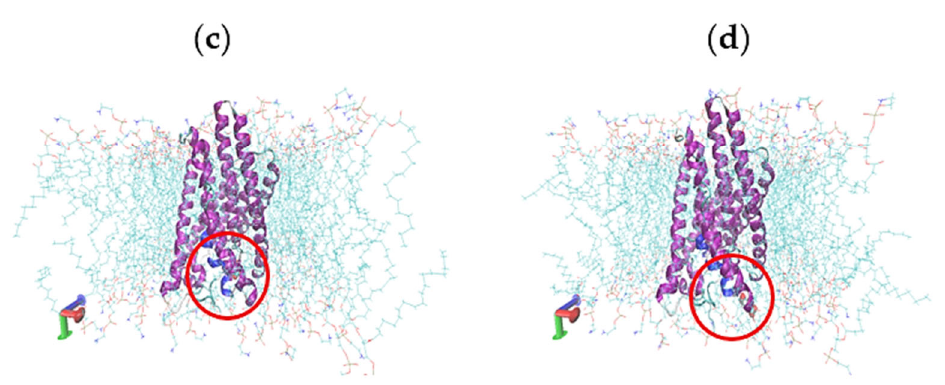
Figure 8. The binding conformations and molecular interaction of MT-CIT system versus molecular dynamics simulation course at ( a ) 0 ns, ( b ) 10 ns, ( c ) 20 ns, ( d ) 30 ns with MT depicted in the cartoon, membrane indicated with a line, and the ligand drawn as a circle.